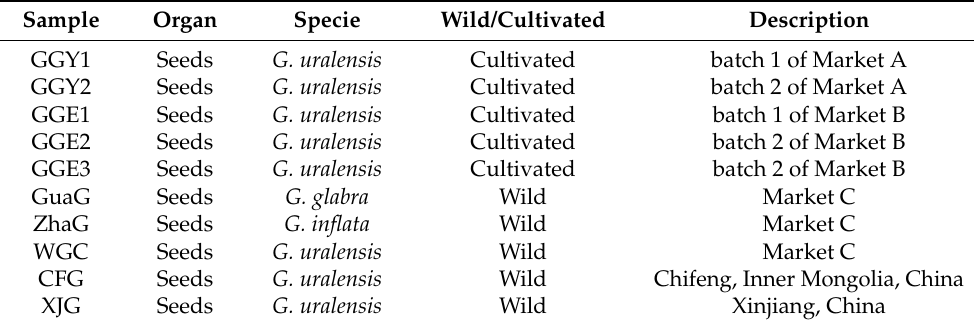
Table 3. Information on ten samples of licorice seeds.